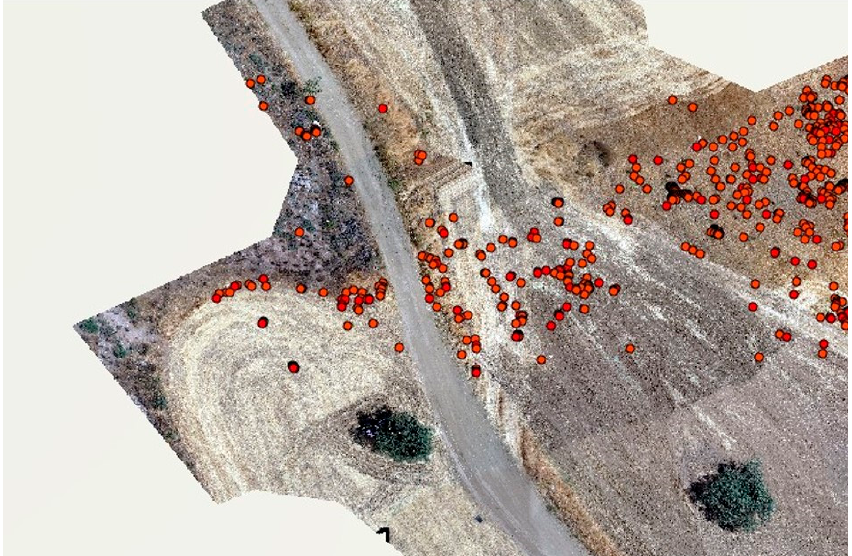
Figure 11. Preliminary results of surface archaeological ceramics using semi-automatic detection methods and low-altitude remote sensing sensors (Red dots indicate positive detections classified as ceramics after the implementation of RF classifier).